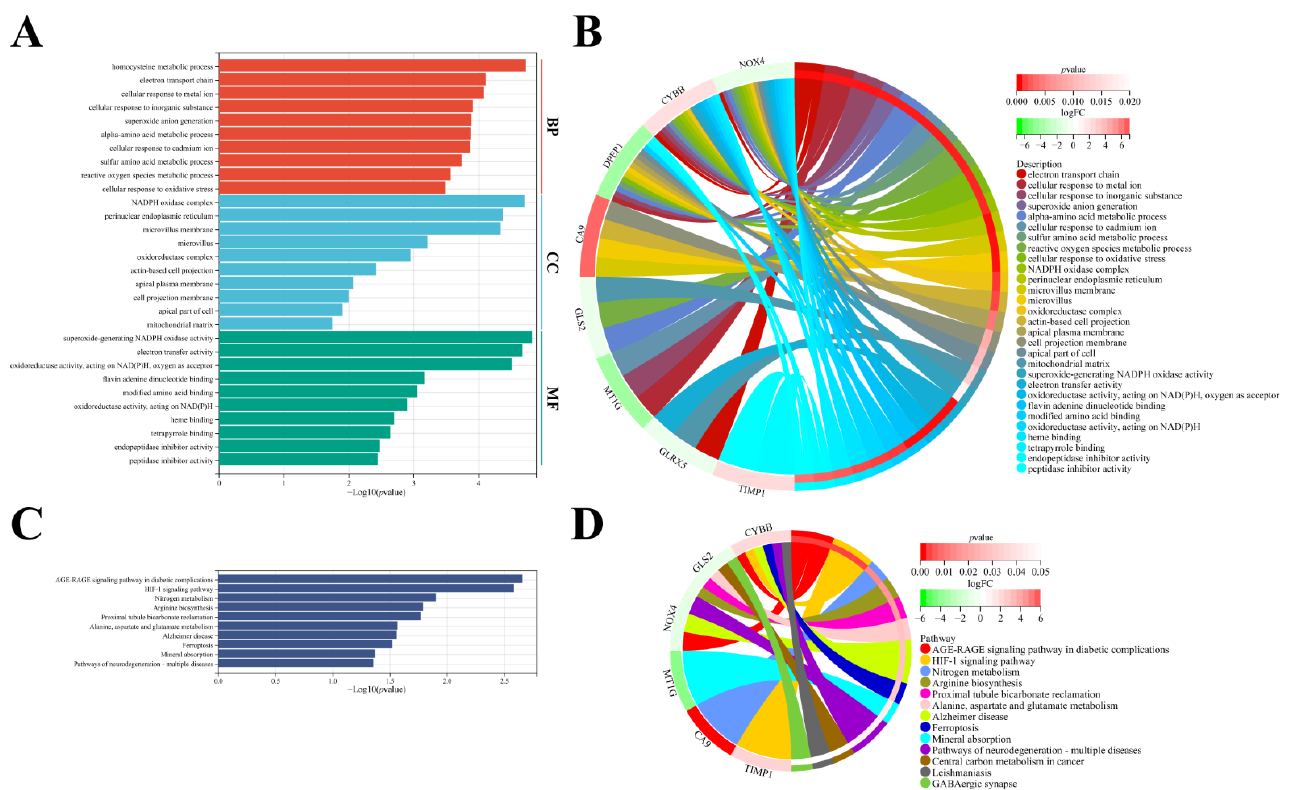
Figure 6. Enrichment analysis of nine FPDEGs. ( A , B ) Top ten enriched terms of nine FPDEGs in BP, CC, and MF. ( C , D ) Ten KEGG terms of nine FPDEGs.